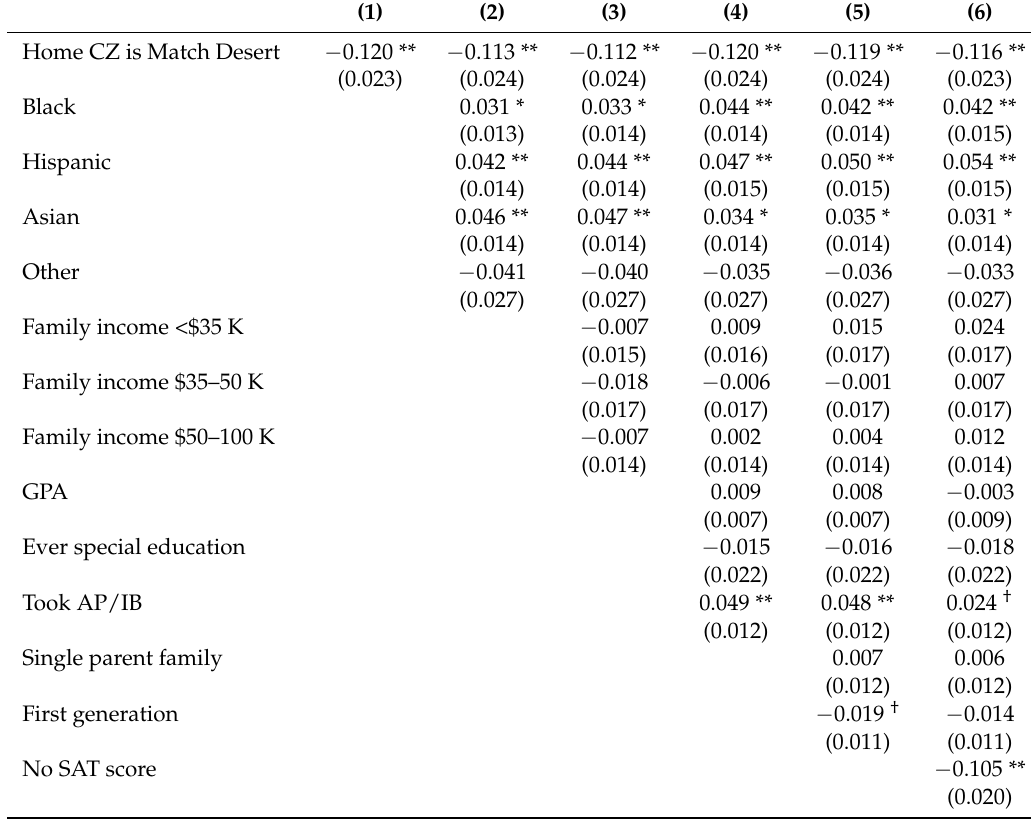
Relationship between living in match desert and applying to an